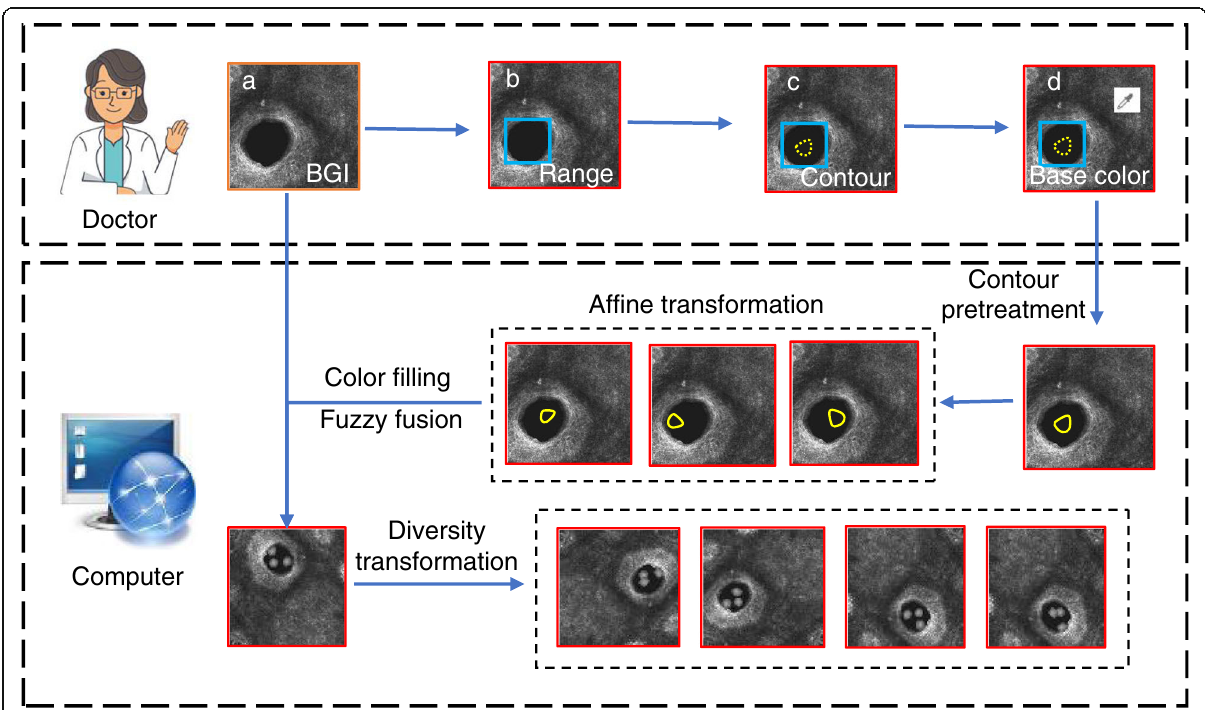
Fig. 2 Implementation of ZSAL. Implementation of ZSAL includes five steps: a medical image that does not contain lesions is selected by the expert doctor as a background image. The expert doctor selects the range of the lesions in the BGI. The expert doctor depicts texture features such as the contour of the lesion on the background image. The expert doctor selects a base color from the palette as the color of M to fill the lesion. The affine transformation, the color gradient filling, diversity transformation, and the fuzzy fusion method are used to generate a zero sample augmentation data